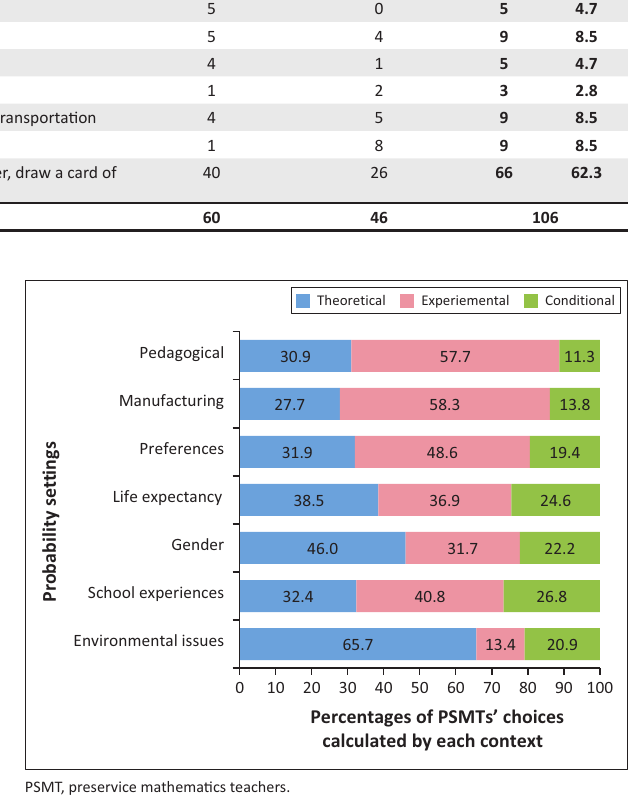
FIGURE 1: Preservice mathematics teachers’ determination of the probability